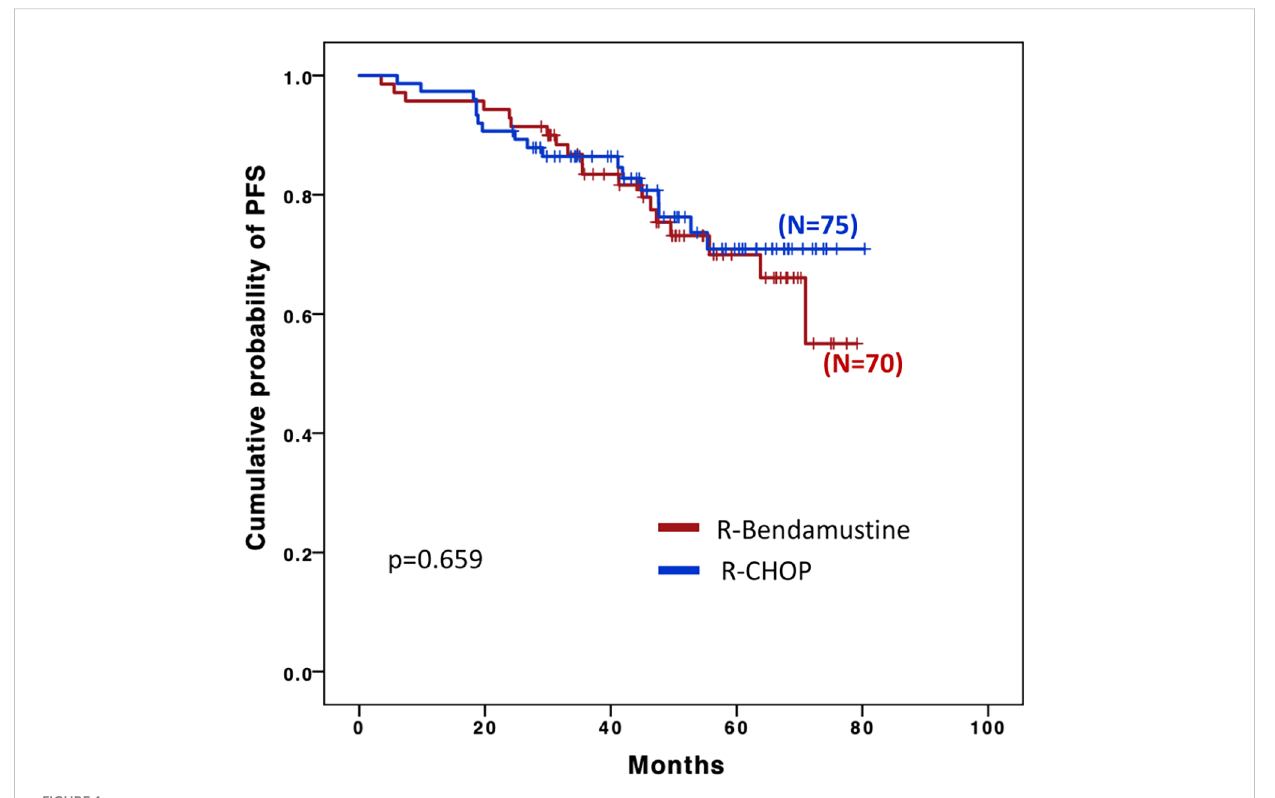
FIGURE 1 Progression-free survival